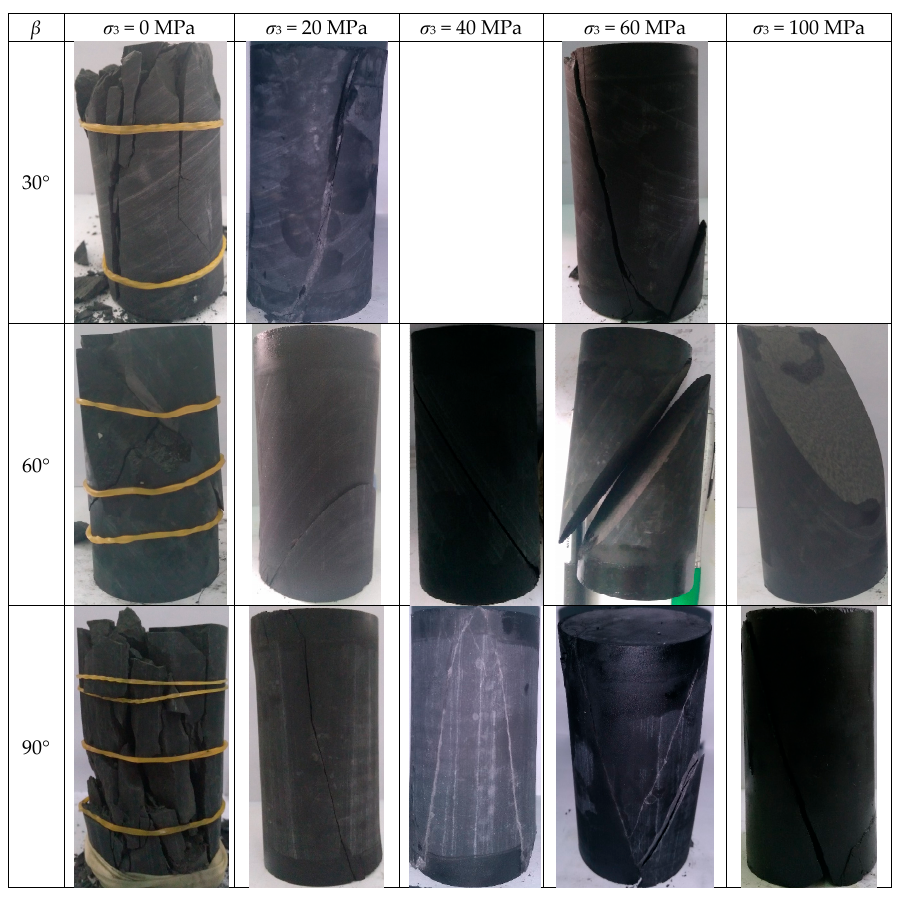
Figure 6. Fracturing patterns the Shale samples with different oriented weak planes under the cyclic loading and unloading experiments under different confining pressures (Some of the pictures have been shown in [41]).